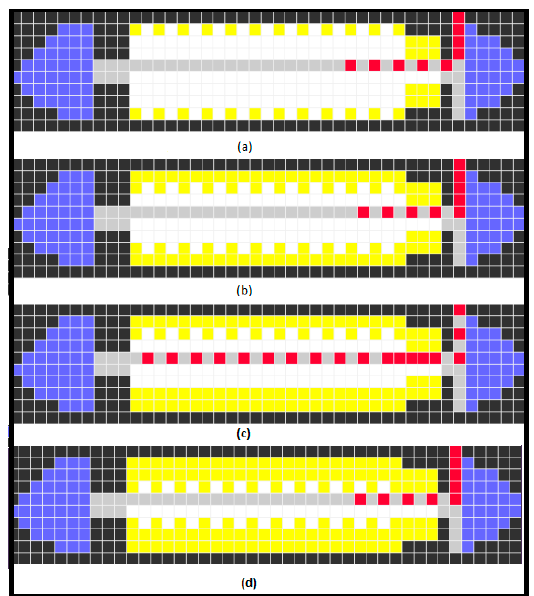
Figure 27. Optimal strategy.